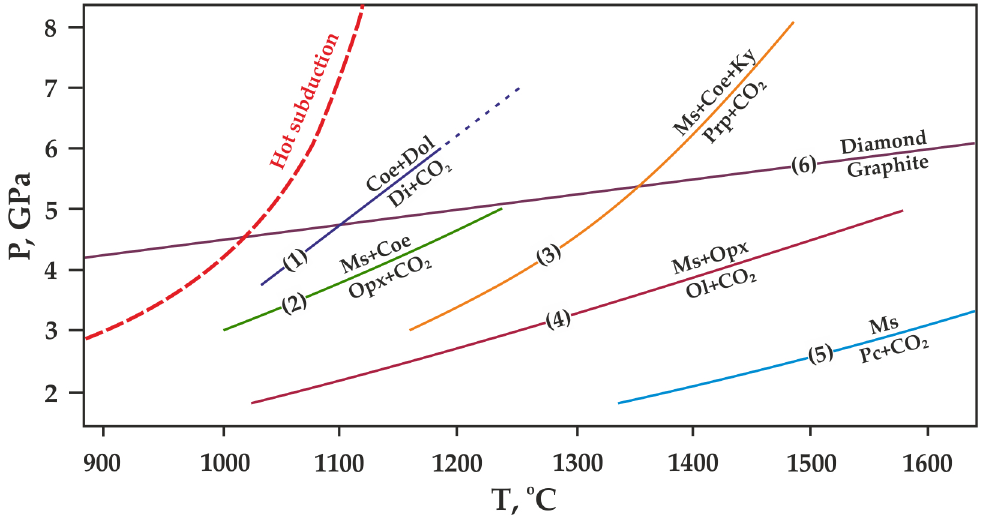
Figure 3. P,T diagram with previously constrained decarbonation curves, resulting in the formation of CO 2 fluid and (1) diopside [17], (2) orthopyroxene [15,19], (3) pyrope [20], (4) olivine [13,14], (5) periclase [6]. The graphite-diamond direct transition line (6) is given according to [48].